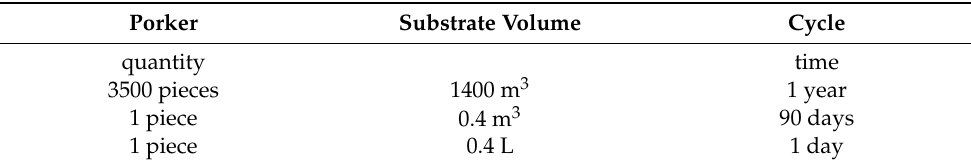
Table 3. Summary of substrate production (pig slurry) necessary for the fermentation process [own